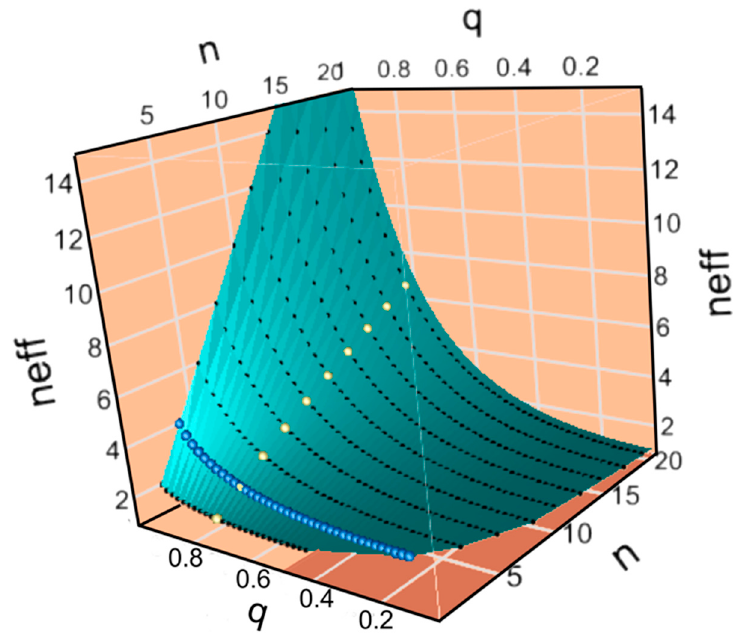
Figure 3. Errors reduce the effective alphabet size, n eff , and the information available for functional use, inducing very significant variation over the {n, q} surface. For reference here and in Section 3.3, the alphabet size of nucleic acid bases, n = 4, is marked by blue spheres. The locus of points with q = 0.8 is marked by yellow spheres. Note that n eff approaches the size of the Standard Genetic Code alphabet only when q → 1.